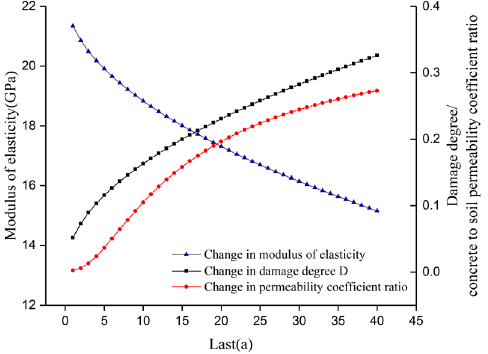
Figure 6. Characteristic curves of calculated parameters of culvert damage analysis with different calendar time.